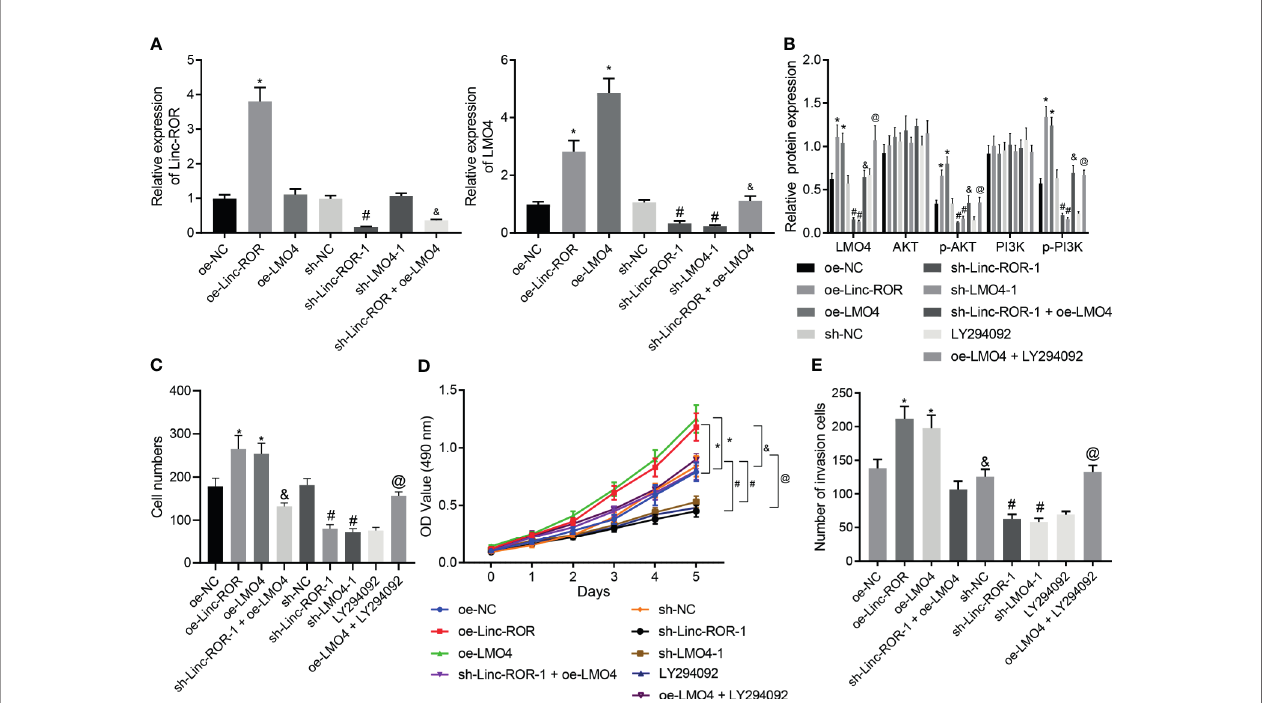
FIGURE 4 | Linc-ROR promotes HNSCC cell proliferation and invasion via LMO4-mediated AKT/PI3K pathway activation. (A) The detection of Linc-ROR and LMO4 expression by RT-qPCR in TSCCA cells upon overexpression or silencing of LMO4 or Linc-ROR, sh-Linc-ROR + oe-LMO4, LY294002 or oe-LMO4 + LY294002. * p < 0.05, compared with the oe-NC group, # p < 0.05, compared with the sh-NC group; & p < 0.05, compared with the oe-LMO4 group; (B) Protein expression of LMO4, AKT, and PI3K along with p-AKT and p-PI3K in TSC7CA cells upon overexpression or silencing of LMO4 or Linc-ROR, sh-Linc-ROR + oe-LMO4, LY294002 or oe-LMO4 + LY294002. * p < 0.05, compared with the oe-NC group, # p < 0.05, compared with the sh-NC group; & p < 0.05, compared with the oe-LMO4 group; @ p < 0.05, compared with the LY294002 group; (C) Proliferation of TSCCA cells measured by monoclonal formation assay upon overexpression or silencing of LMO4 or Linc-ROR, sh-Linc-ROR + oe-LMO4, LY294002 or oe-LMO4 + LY294002; * p < 0.05, compared with the oe-NC group, # p < 0.05, compared with the sh- NC group; & p < 0.05, compared with the oe-LMO4 group; @ p < 0.05, compared with the LY294002 group; (D) Proliferation of TSCCA cells measured by MTT assay upon overexpression or silencing of LMO4 or Linc-ROR, sh-Linc-ROR + oe-LMO4, LY294002 or oe-LMO4 + LY294002. * p < 0.05, compared with the oe-NC group, # p < 0.05, compared with the sh-NC group; & p < 0.05, compared with the oe-LMO4 group; @ p < 0.05, compared with the LY294002 group; (E) , Invasion of TSCCA cells measured by Transwell assay upon overexpression or silencing of LMO4 or Linc-ROR, sh-Linc-ROR + oe-LMO4, LY294002 or oe-LMO4 + LY294002. * p < 0.05, compared with the oe-NC group, # p < 0.05, compared with the sh-NC group. & p < 0.05, compared with the oe-LMO4 group; @ p < 0.05, compared with the LY294002 group. All experiments were repeated three